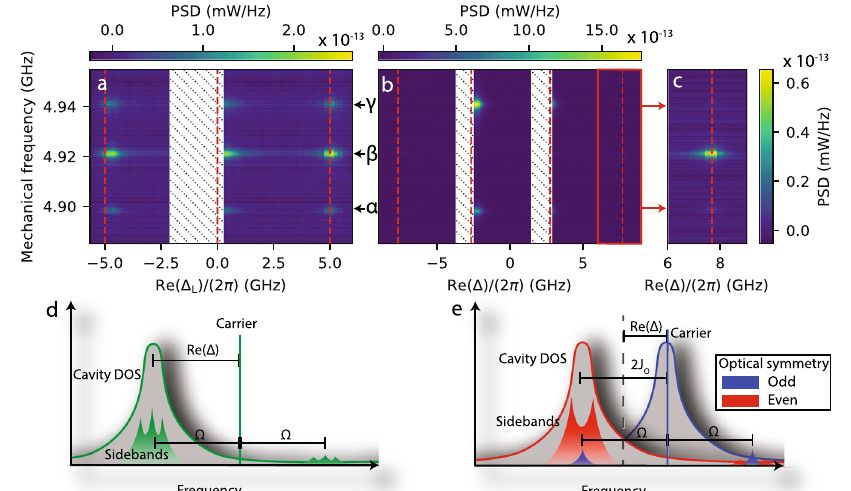
Fig. 3 | Linear transduction of mechanical modes with different symmetries. Panels a – c show spectrograms of photocurrent PSD for various laser-cavity detunings Δ normalised to 1 μ W input power. a Spectrogram for detuned cavities. b Spectrogram for a tuned cavity, with c an additional narrow sweep with more optical power, scaled to match data in ( b ). Hatched regions indicate Δ values not accessible due to thermo-optical bistability. The vertical dashed lines represent resonant detunings, where either carrier or sideband resonates with an optical